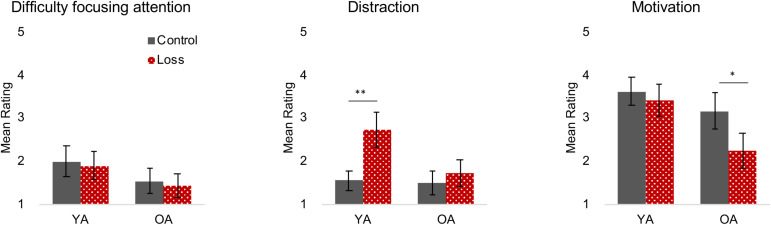
State Attention and Motivation Questionnaire (SAMQ) (Q4–Q6). Different colors/patterns (control = black filled, loss = red dotted) are used to highlight the different conditions for young (YA) and older adults (OA). Error bars represent 95% confidence intervals. **p < 0.001, *p < 0.01. Loss incentive increased distraction for young adults and decreased motivation for older adults.